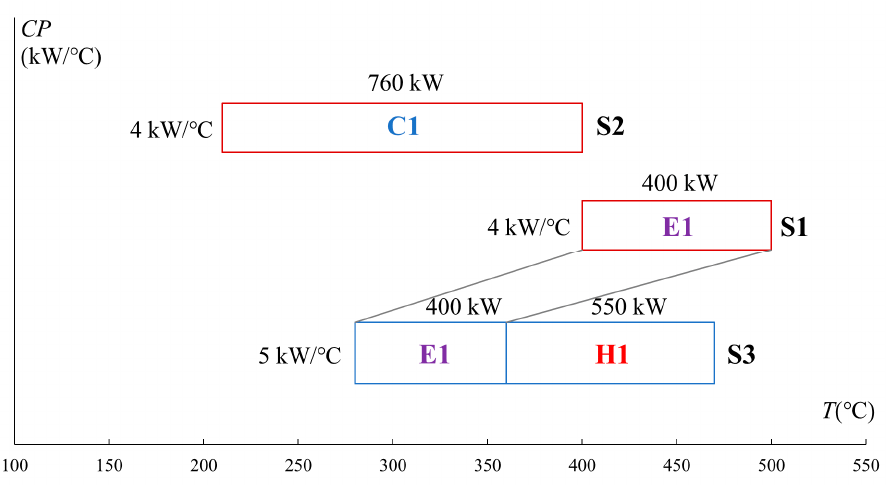
Figure 1. Shifted Retrofit Thermodynamic Grid Diagram (SRTGD) of the existing HEN for Example 1.